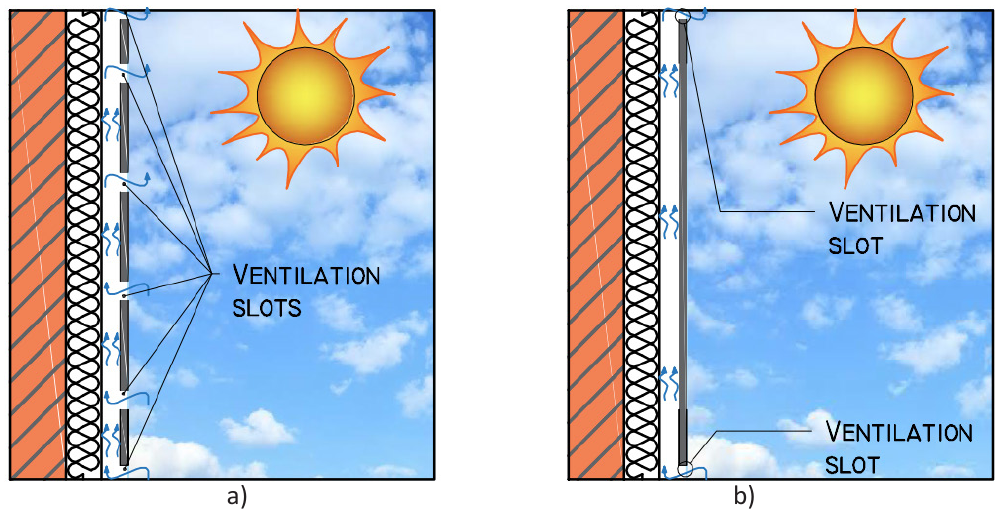
Figure 3: Types of ventilated facades: a) with open joints; b) with closed joints